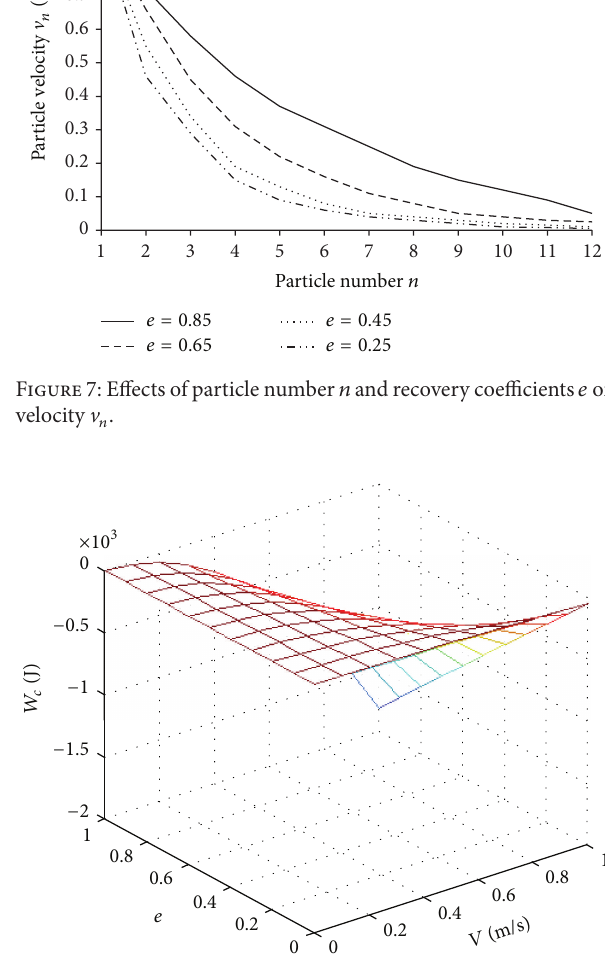
Figure 8: Effects of recovery coefficients 𝑒 and initial velocity 𝑉 on energy dissipation 𝑊 𝑐